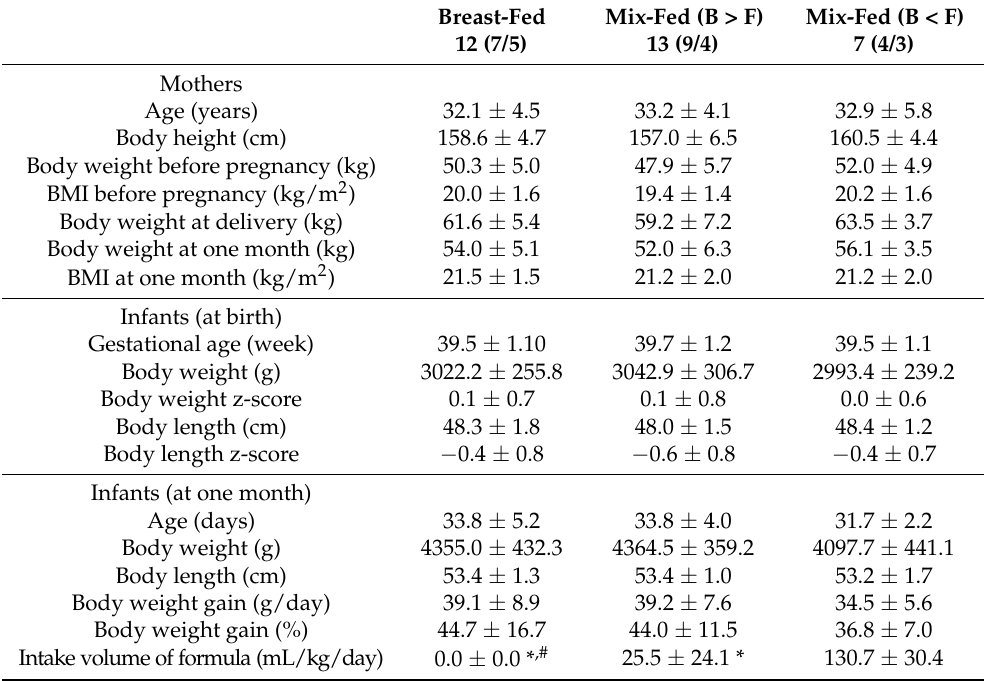
Table 1. General characteristics of the subjects.